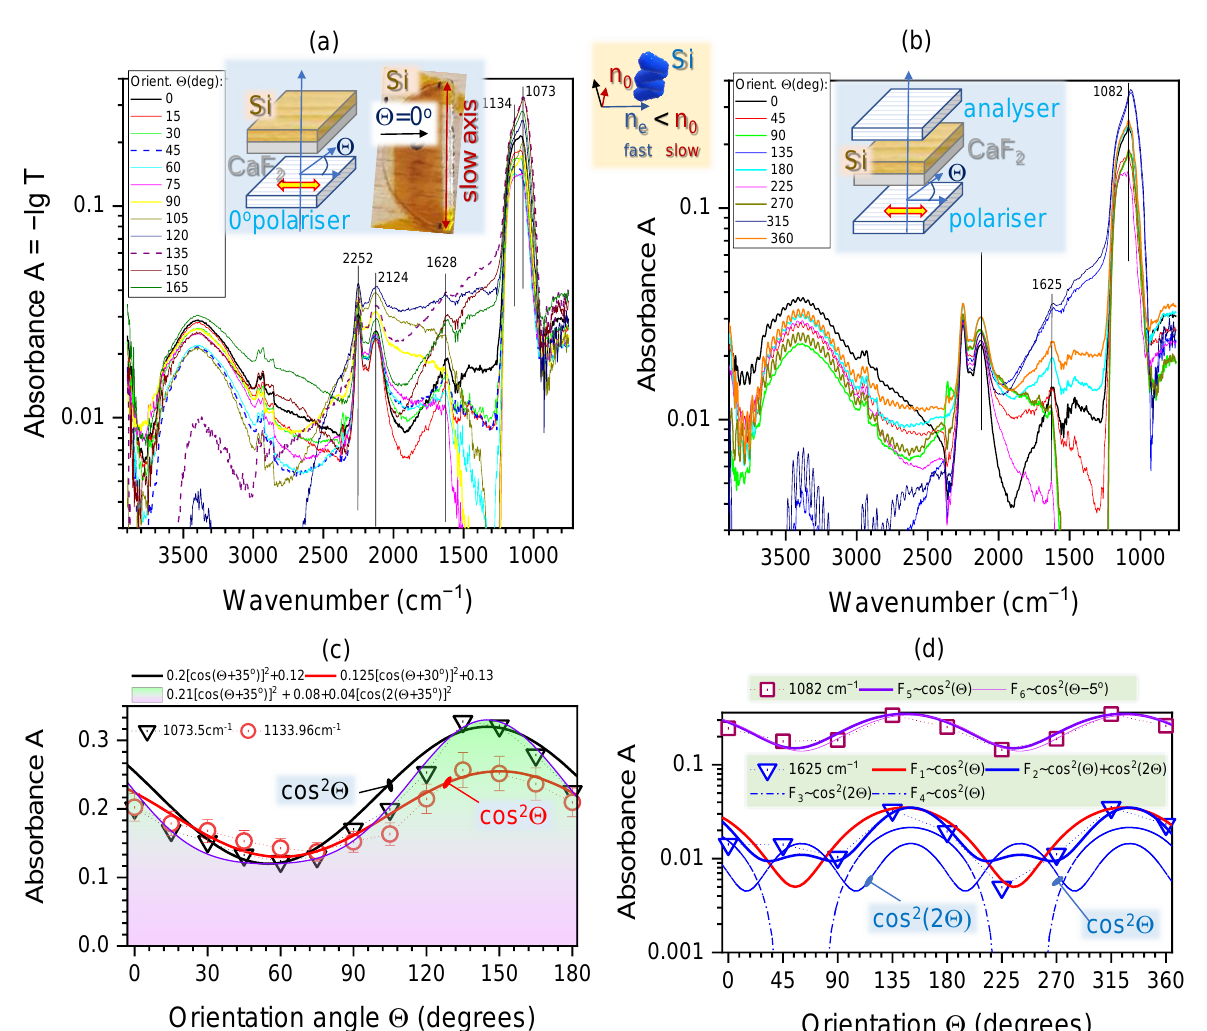
Figure 2. Polarisation analysis of the absorption bands. ( a ) Spectra at various polarisation orientations of θ for an analyser only setup. Inset shows geometry of experiment and a top-view photo of the sample with θ = 0 ◦ along the fast-axis ( n e index); slow-axis ( n o ) is at θ = 90 ◦ . Positive θ corresponds to the anti-clockwise rotation around the z -axis. ( b ) spectra at various orientations of θ polarisation for an aligned polariser–analyser setup; ( c ) orientational dependence of absorbance A ( θ ) of a columnar Si of H ≈ 1 µ m height measured at the polarised irradiance; reference was CaF 2 substrate. Error bars mark ± 10% uncertainty band; ( d ) the dependence A ( θ ) and spectra measured through an aligned polariser–analyser pair (high transmission mode). Focal spot size 16.7 µ m; Polariser is KRS-5 and Analyser ZnSe (see insets and Figure 1); spectral resolution 4 cm − 1 . See details in the text. Note the